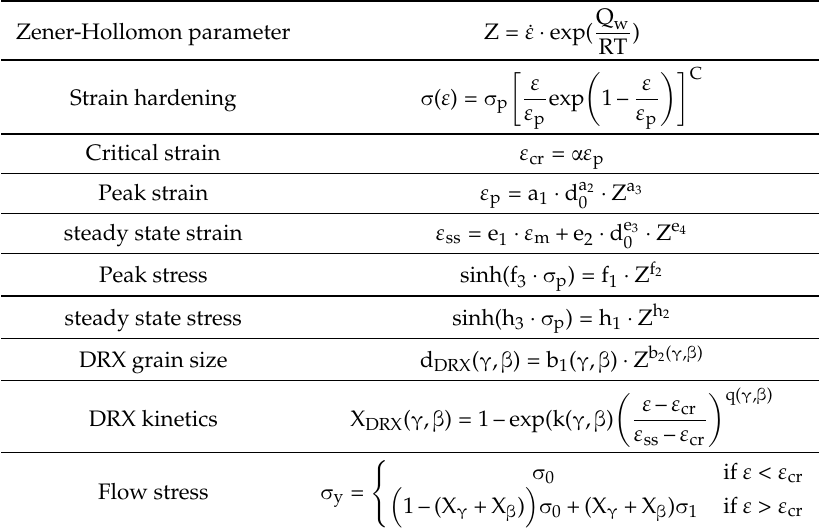
Table 2. Overview of the model equations used in the phenomenological